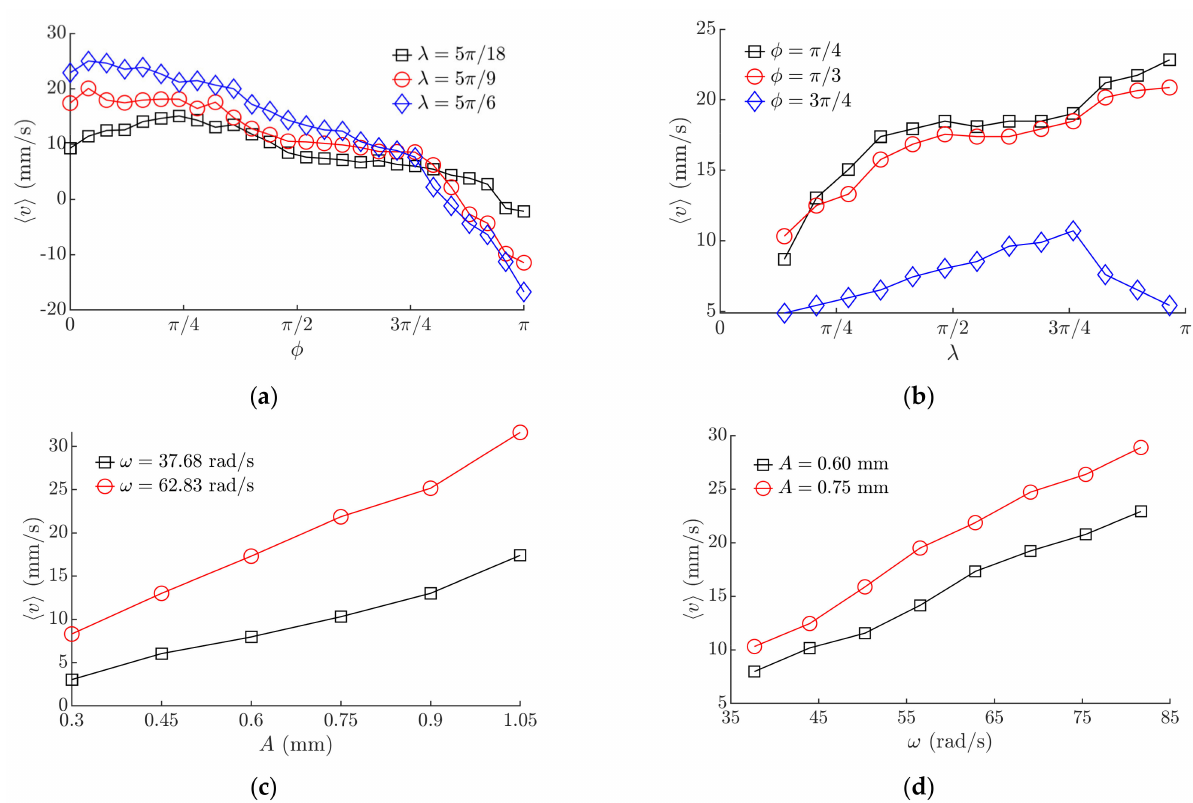
Figure 8. Average velocity of the miniature body depending on: ( a ) phase shift φ when A = 0.6 mm, ω = 62.83 rad/s; ( b ) λ when A = 0.6 mm, ω = 62.83 rad/s; ( c ) amplitude of the harmonic excitation when φ = π /6, λ = 4.1 π /9 ( d ) angular frequency of the harmonic excitation when φ = π /6, λ = 4.1 π /9.